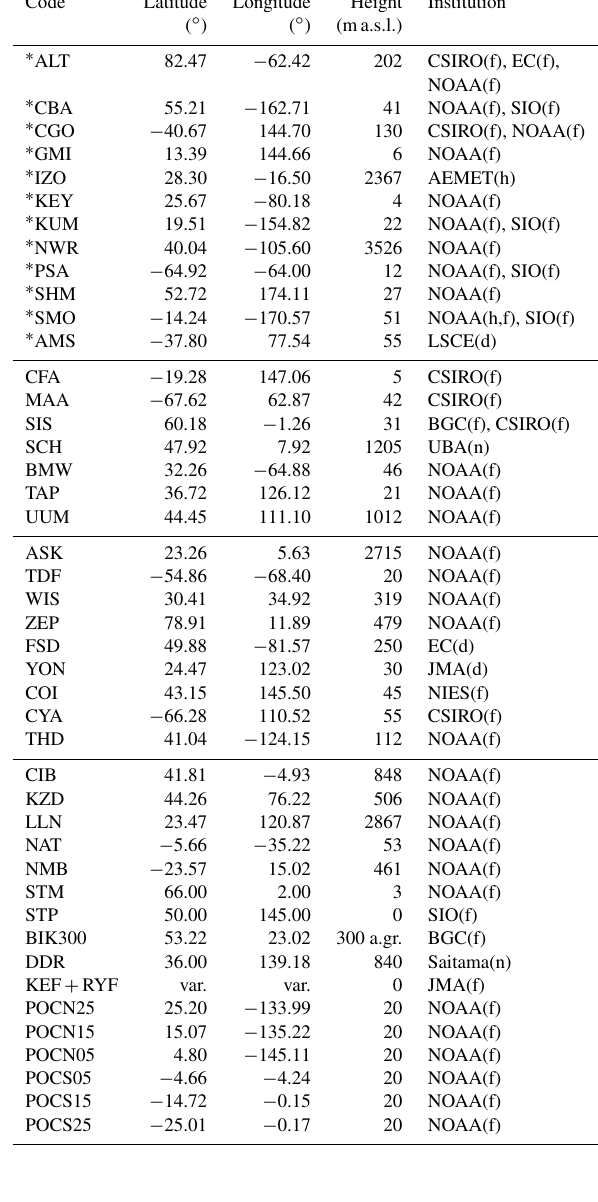
Table 1. Atmospheric CO 2 measurement stations used in the NEE– T inversion. The smaller set of stations used in the standard inver- sion is labelled with an asterisk. The eight parts individually omitted in sensitivity tests are separated by horizontal lines. Institutions